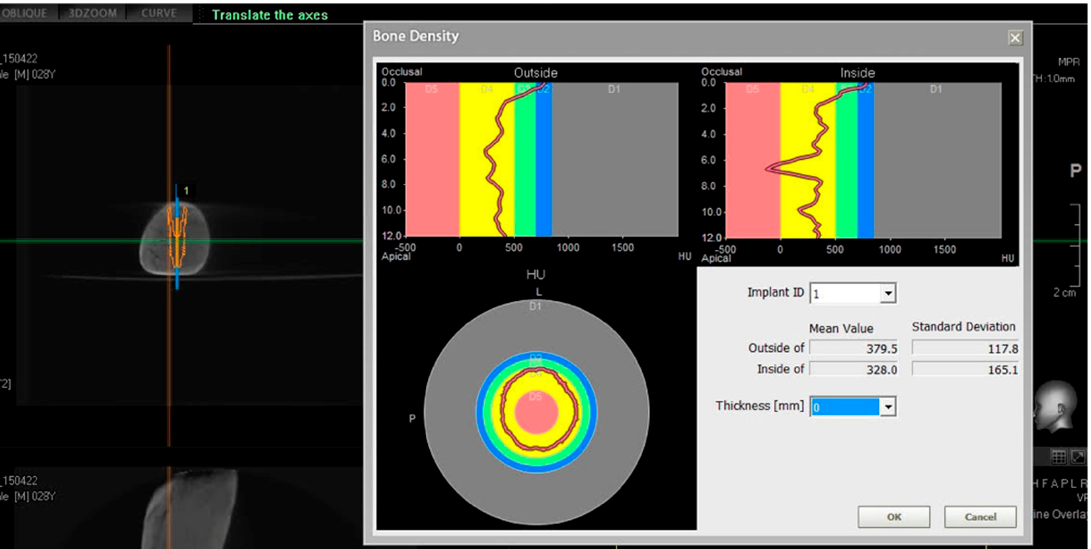
Figure 2. Scanning of the ribs with CBCT scan (Pax i-3d Green, Vatech, Yongin, Korea) to evaluate bone density and select implant site, using Hounsfield measurement unit (Density of 750 < HU).